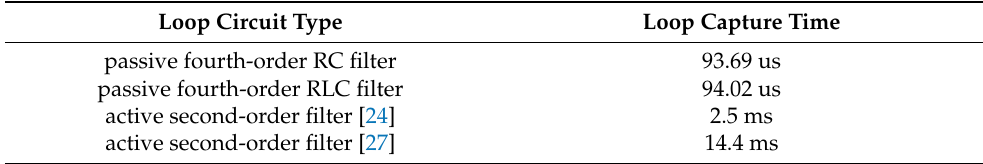
Table 7. Comparison of loop capture times of different filters.